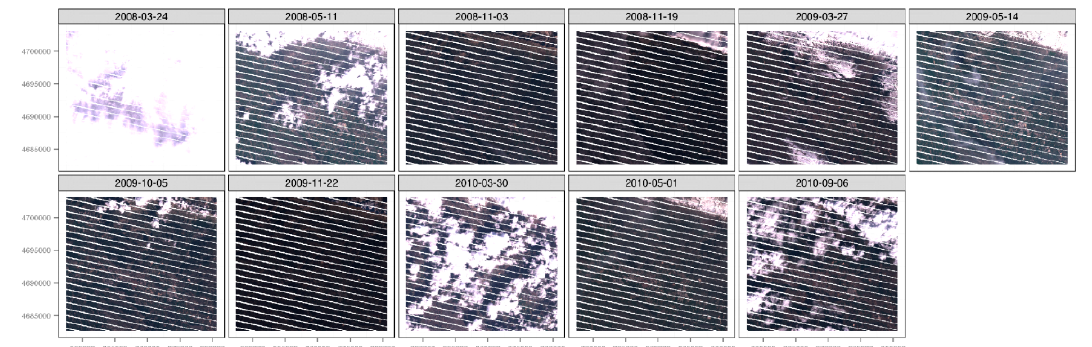
Figure 4. The complete image set of the Landsat ETM+ scenes where the three bands (red, green blue) acquired in the visible spectrum were blended together (Red, Blue and Green (RGB) composite), projected to UTM33N WGS84 datum, images are around 23 km in width.